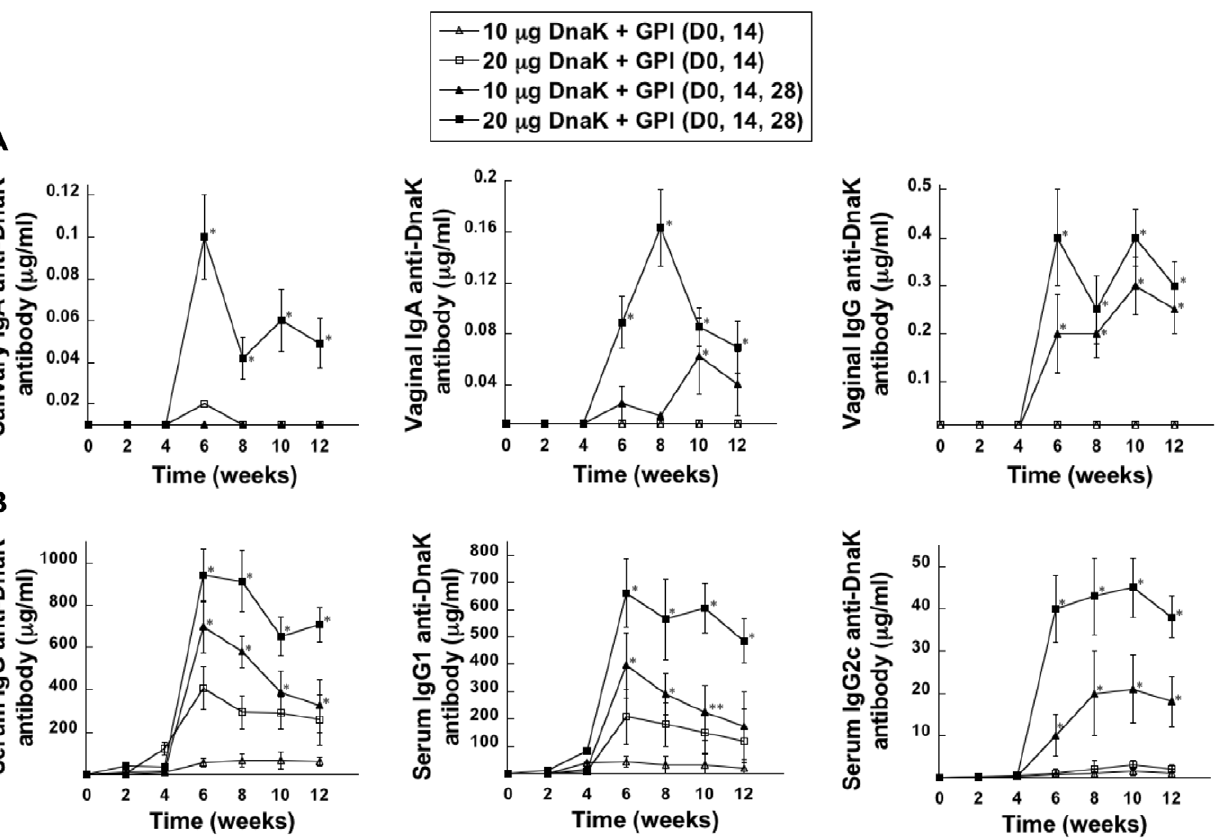
Figure 2. DnaK-specific mucosal and serum antibody responses following i.n. immunization with DnaK + GPI. Mice were immunized via the i.n. route with DnaK (10 or 20 m g) + GPI (100 m g) on days 0 and 14 or on days 0, 14 and 28. Individual saliva, vaginal wash and serum samples were collected prior to and at approximately 2-week intervals following immunization. Levels of DnaK-specific IgA in the saliva and vaginal wash samples and IgG in the vaginal wash samples (A), and of IgG, IgG1 and IgG2c in the serum (B), were determined by ELISA. There were 6 mice per experimental group and values are expressed as the mean 6 SEM. Significant differences were seen at P , 0.001 (*) and P , 0.01 (**) compared with mice receiving only two immunizations with equivalent doses of DnaK and